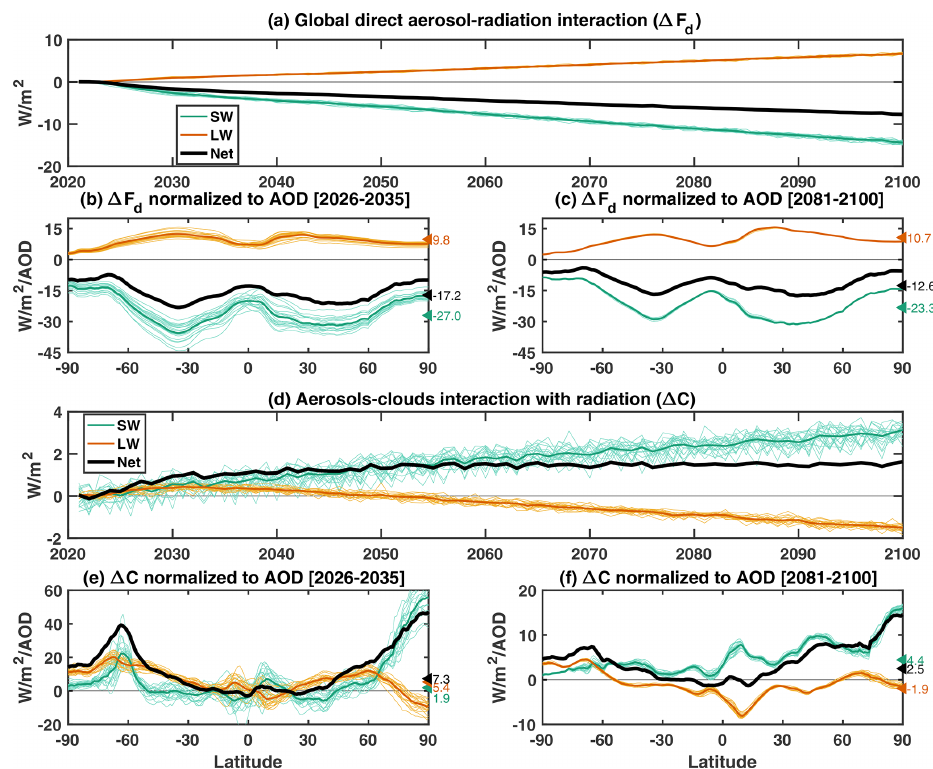
Figure 7. Global mean evolution of TOA radiative fluxes in the LW (orange), SW (green) and Net (black) for the forcing directly produced by the aerosols (cid:49) F D (a) and by the clouds as changed by the presence of the aerosols ( (cid:49) C ) (d) . In panels (b) – (c) and (e) – (f) , respectively, the latitudinal breakdown of the global fluxes in two periods (2026–2035 and 2081–2100) is shown for the various components. To the right of each panel, the global mean in the considered period is shown with a triangle of the same color, and the value is given on the right. Thinner lines show the single ensemble realizations, while the thicker lines show the ensemble